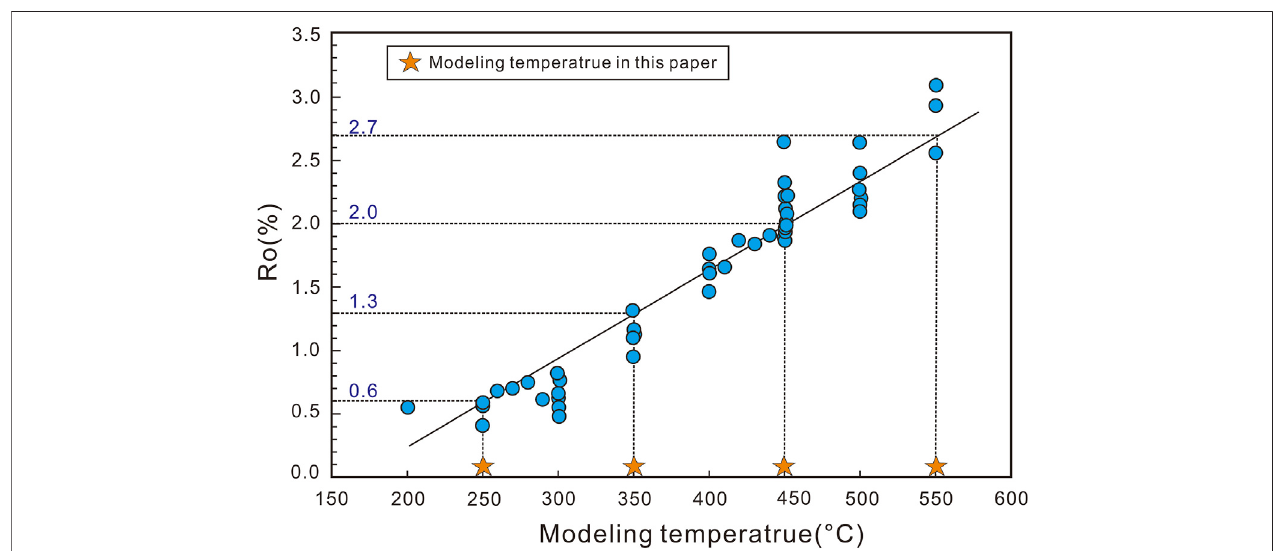
FIGURE 2 | Relationship between simulated temperature and measured vitrinite re fl ectance (R o ) (modi fi ed after Wu et al., 2015).